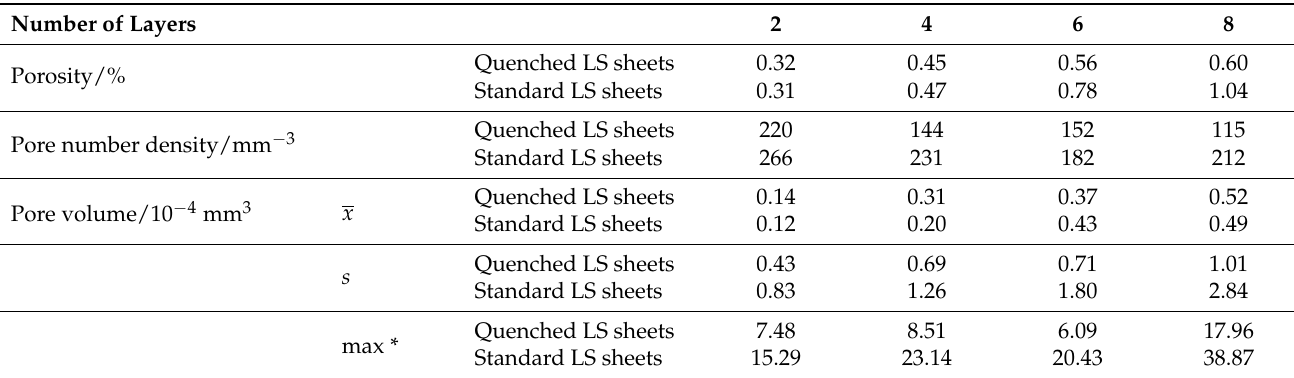
Table 2. Porosity, pore number density, and average value ( x ), standard deviation ( s ), and maximum value (max) of pore volumes measured by X-ray micro-computed tomography (CT) for quenched and standard laser-sintered (LS) polyamide 12 sheets generated with two, four, six, and eight